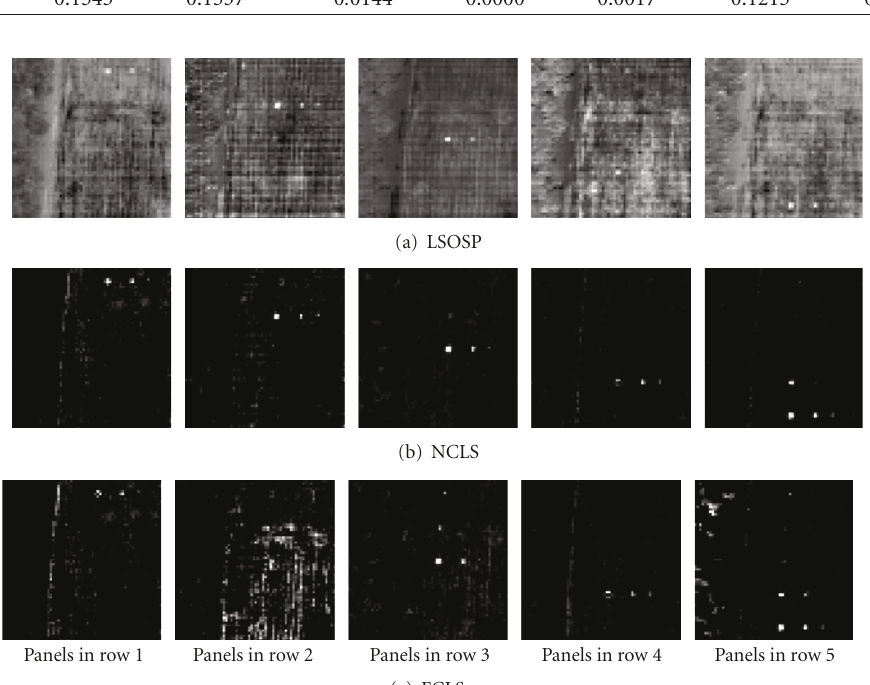
Figure 27: Unmixed results of 15 panels with 19 panel pixels by supervised LSOSP, NCLS, and FCLS using five panel signatures in Figure 17(c) and 4 BKG signatures obtained by marked areas in Figure